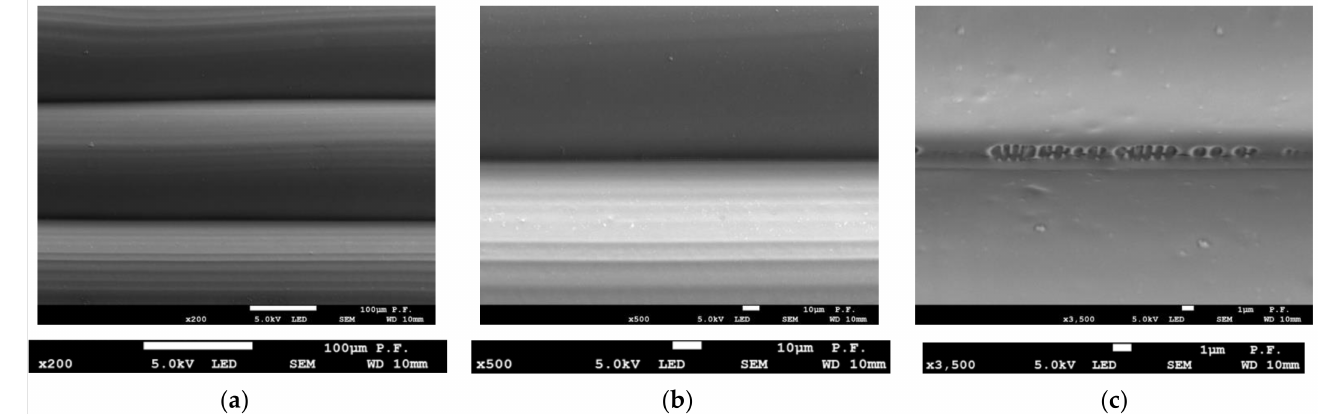
Figure 14. Side views of layers 1.8 mm thick PLA specimen before failure, ( a ) × 100 magnification ( b ) two filaments in